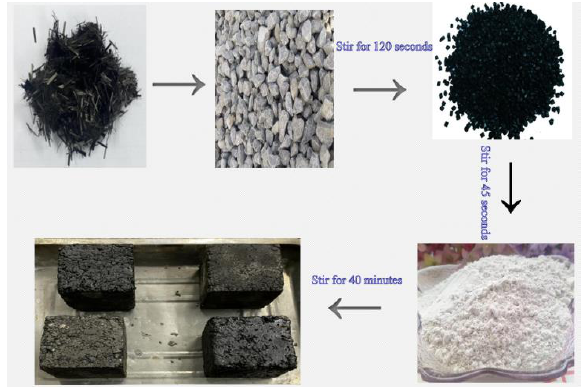
Figure 9. The experimental process. ② Graphene dispersion Because graphene has a large specific surface area and van der Waals force between layers, it is difficult to disperse graphene directly in the asphalt mixture, which limits its practical application. Therefore, in this experiment, graphene was dispersed into the as- phalt in advance by high-speed shear. In the experiment, the shear rate was 5500 r/min, the temperature was 160 °C, and the shear time was 30 min. The test process is shown in Figure 10.